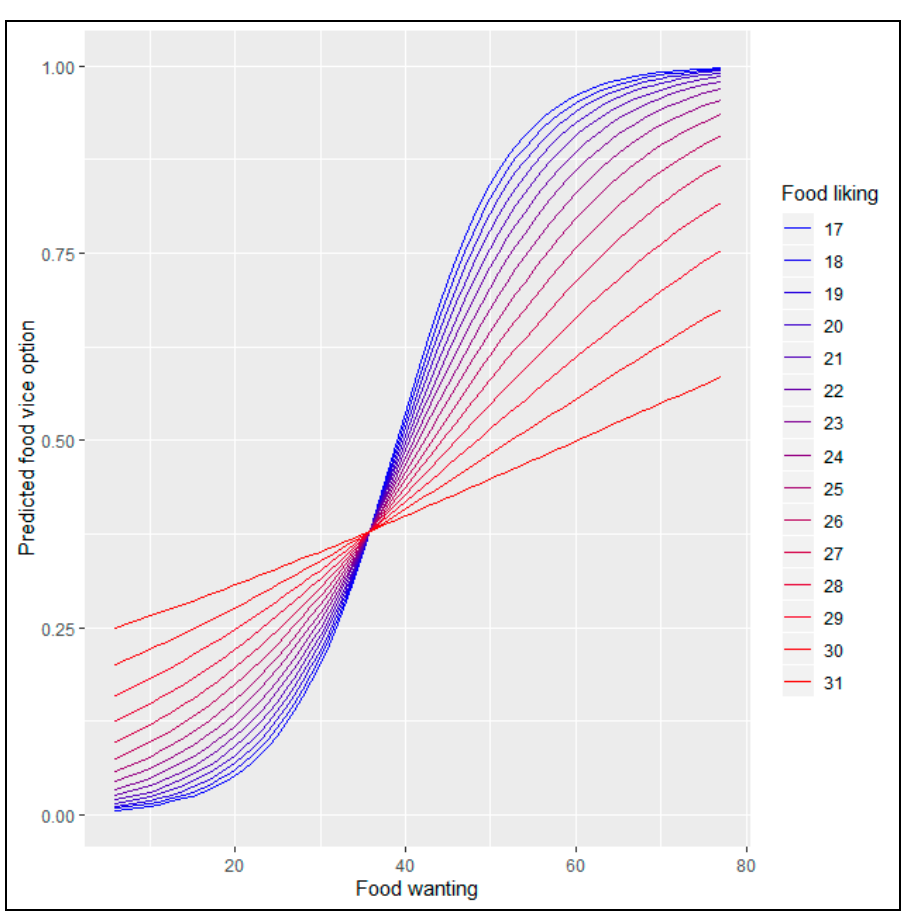
Table 6. Logistic and multinomial regression results. (food choices vs. food liking + food wanting).